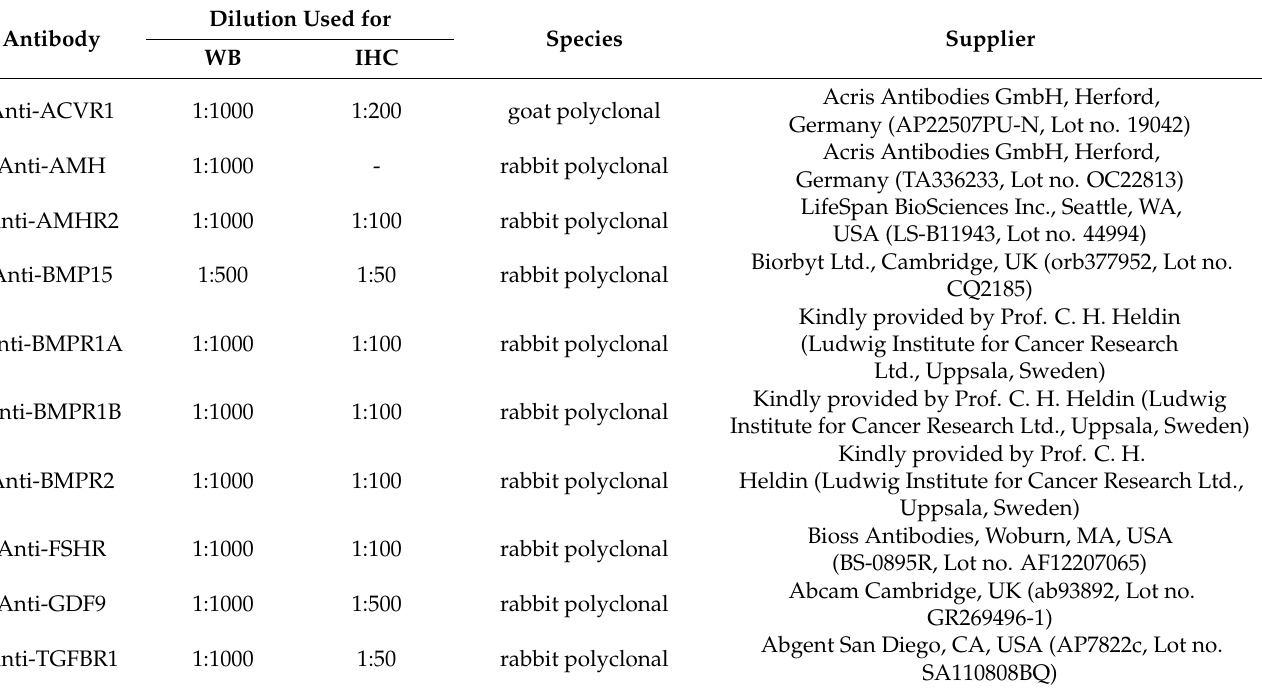
Table 1. List of primary antibodies used for Western blot and